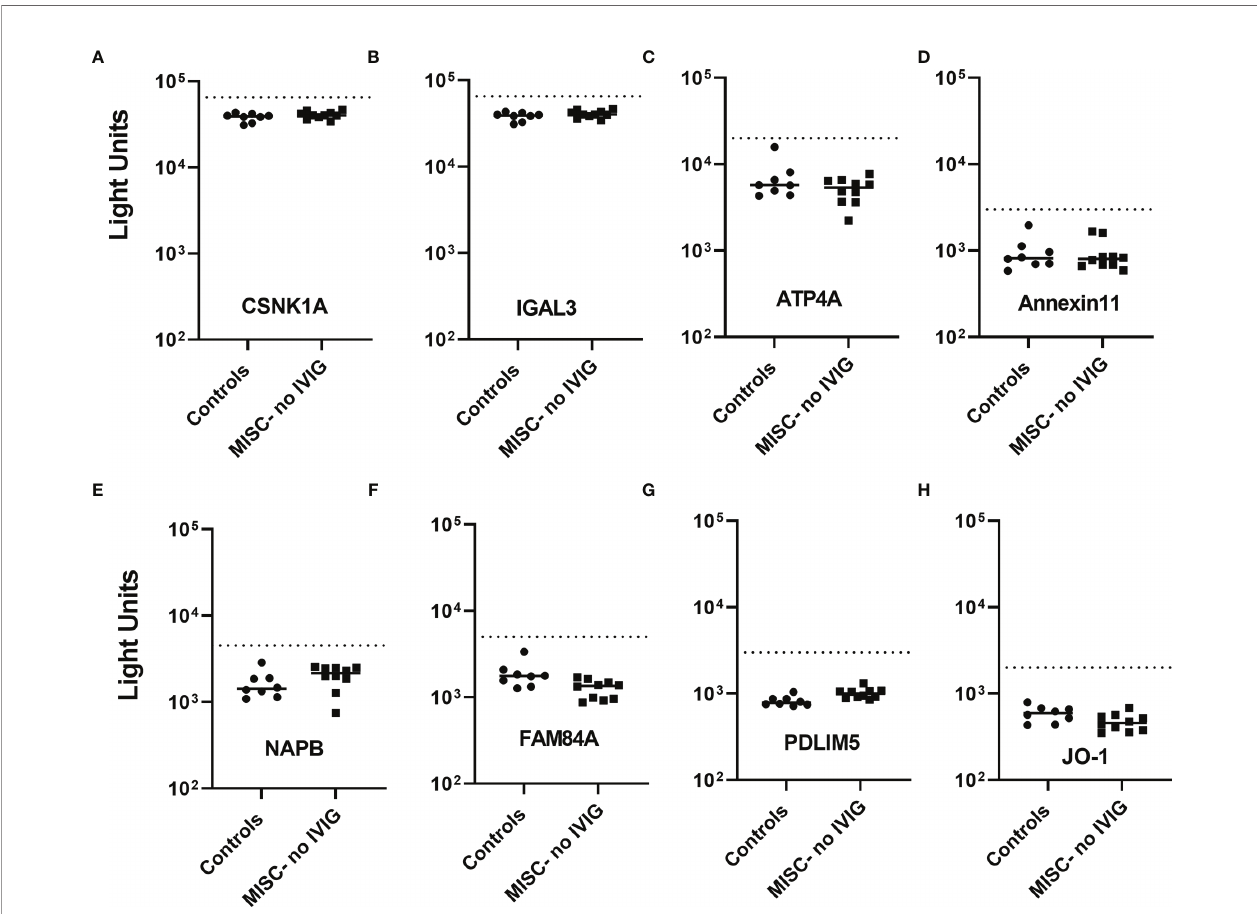
FIGURE 6 | Lack of IgG autoantibodies to previously reported autoantigens in MIS-C. SARS-CoV2 uninfected children (controls) and MIS-C children who did not receive IVIG (MISC-no IVIG) were screened for IgG autoantibodies against potential target proteins (panels A – H ) discovered previously by autoantigen array studies. Autoantibody levels are plotted in light units on a log 10 scale. The dashed lines represent the cut-off level for determining positive antibody titers as described in the Methods. No statistically signi fi cant seropositive autoantibodies in MIS-C were detected in these previous array-identi fi ed